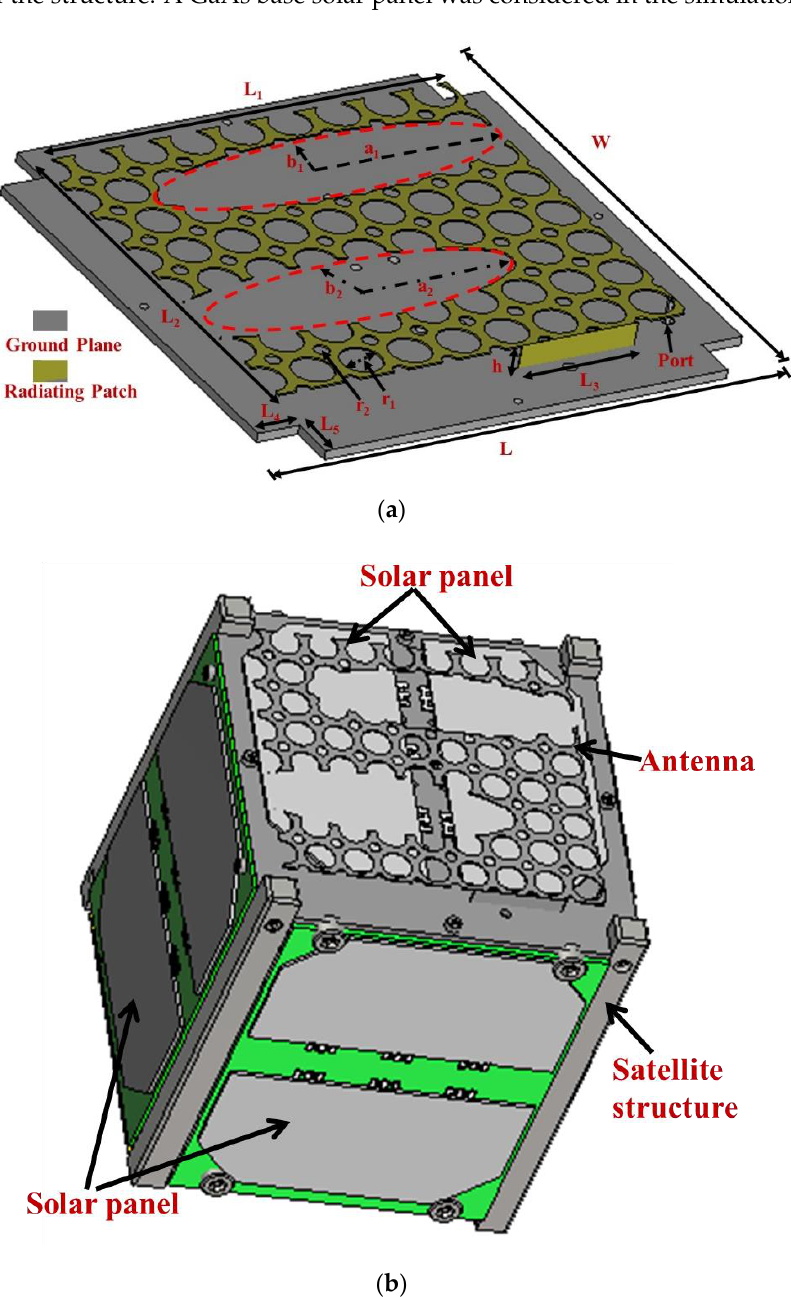
Figure 1. ( a ) Antenna geometry and ( b ) Antenna structure integrated with 1U nanosatellite in simulation environment.